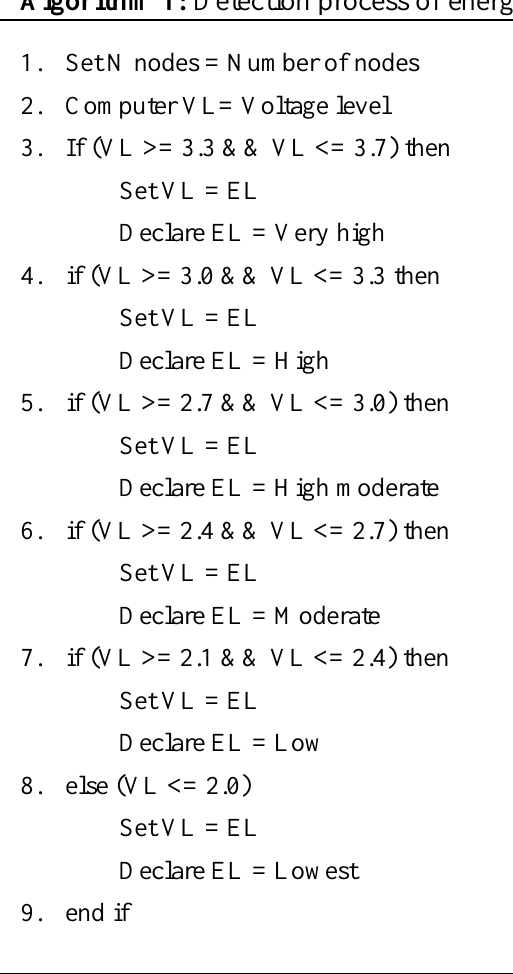
Algorithm 1: Detection process of energy level for selection of boarder